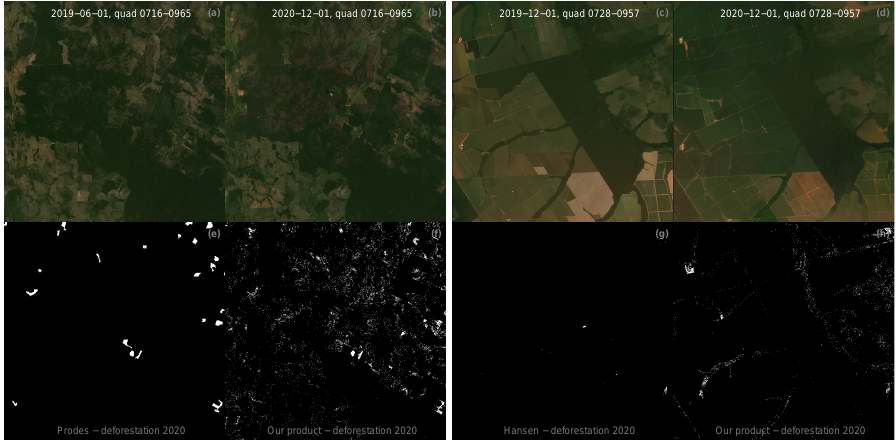
Figure 9. Worst cases of non-agreement between PRODES data (planet quad 0716-0965), Hansen tree cover loss (planet quad 0728-0957), and our product, i.e., < 10% of intersection, for the year 2020. Planet NICFI quad is 19.5 19.5 ∼ ×